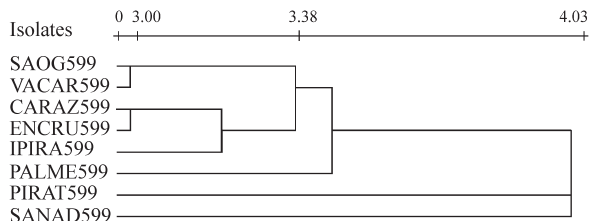
Figure 3 - Dendrogram of the relationships between Drechslera teres iso- lates based on both colony morphology (edge, texture, color and sector) and random amplified polymorphic DNA (RAPD) analysis.